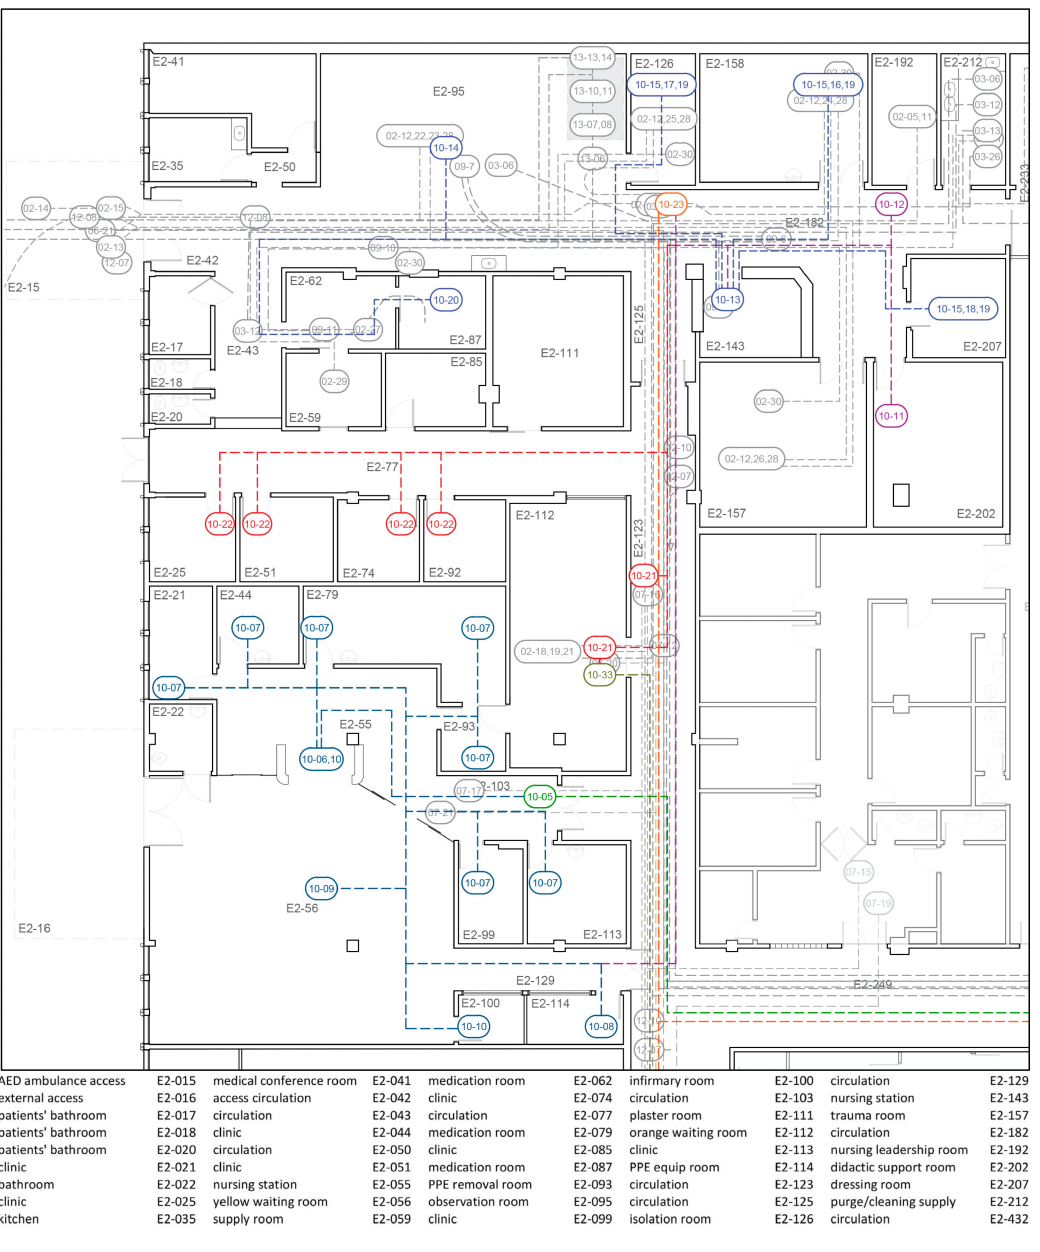
Figure 4. The AED sector plant floor, with an indication of the flow of medical activities, was constructed based on SEF HU USP files. The flow of medical activities is highlighted in color, and the flows of the other roles are indicated in gray. Each color indicates a medical activity sequence. The code with the prefix “E” refers to the listed environments. The codes in balloons refer to the activities. In this case, the number 10 before the hyphen indicates the medical role, and the number after the hyphen indicates the medical activities (activity column in Figure